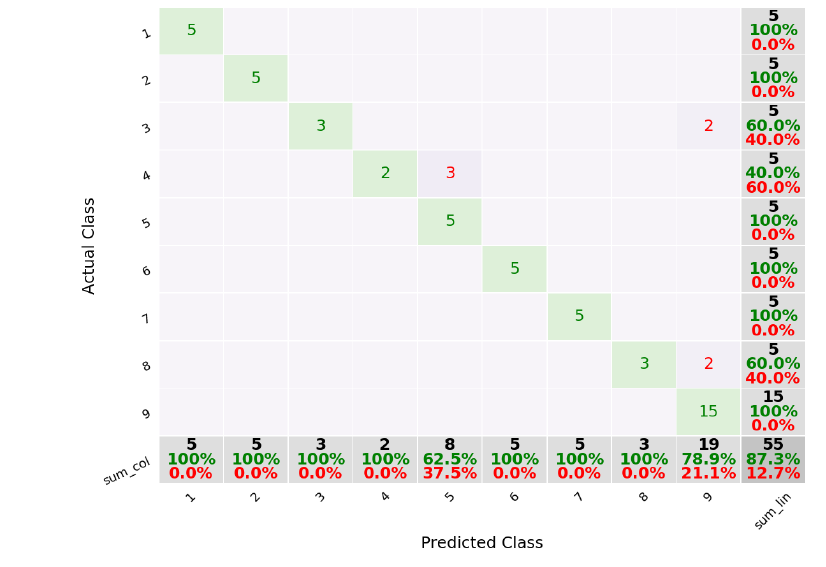
Figure 9. Confusion matrix for 5 continuous sequences using sound features and 3D